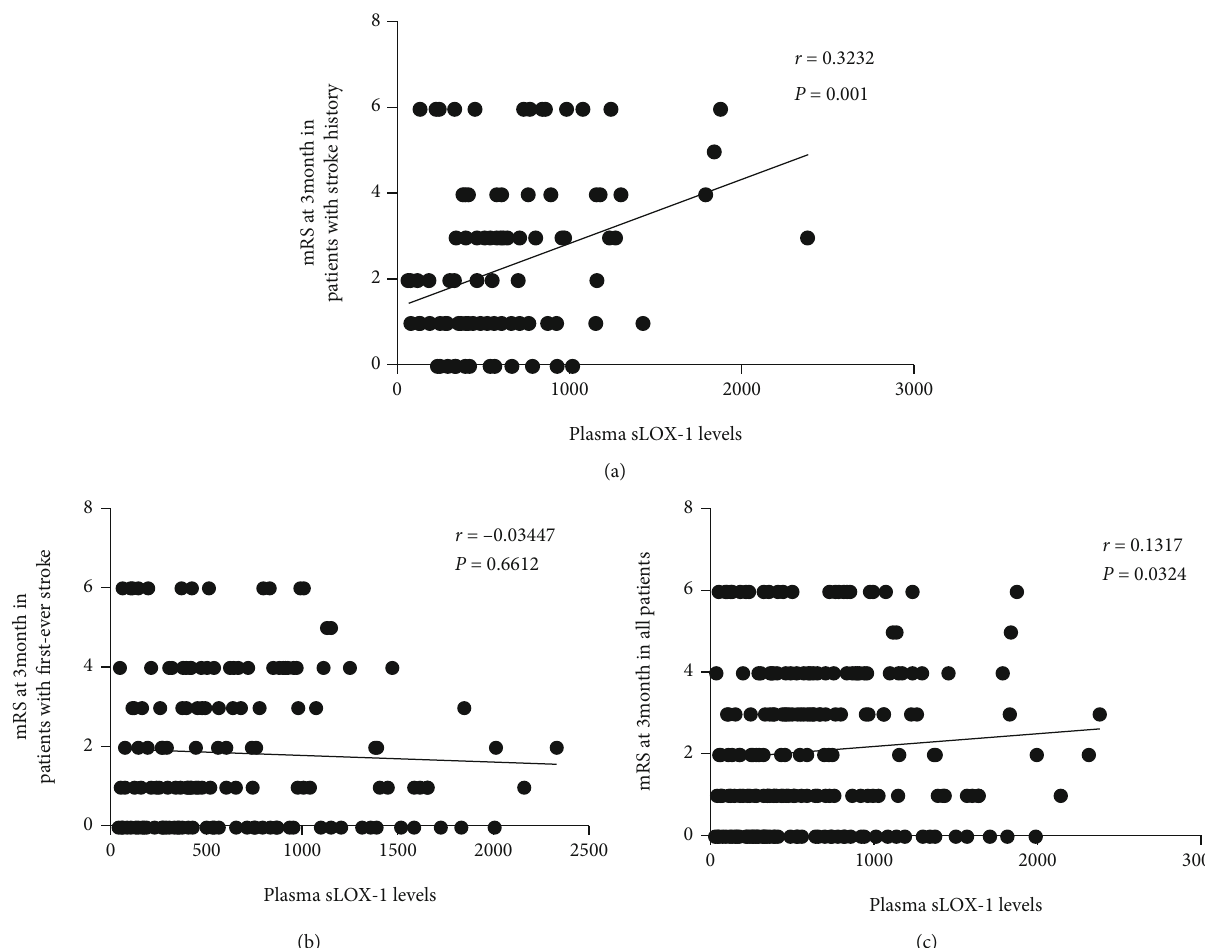
Figure 2: Correlations between sLOX-1 levels and 3-month mRS score. Correlation of 3-month mRS score with the plasma sLOX-1 level in patients with AIS with recurrent ischemic stroke (a), with fi rst-ever stroke (b), and in all patients with AIS (c). N = 101 for patients with recurrent ischemic stroke, N = 165 for patients with fi rst-ever ischemic stroke, and N = 266 for all patients with AIS. AIS: acute ischemic stroke; sLOX-1: soluble lectin-like oxidized low-density lipoprotein receptor-1; mRS: modi fi ed Rankin